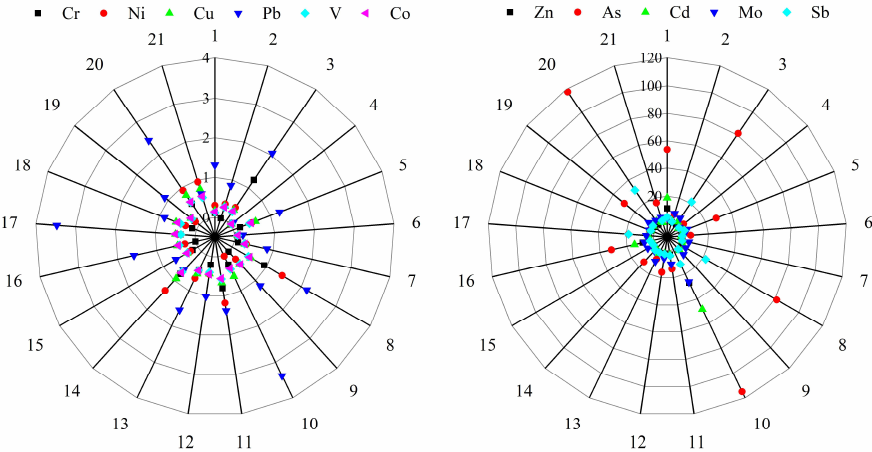
Figure 6. Polar plot of heavy metal enrichment factor (EF) values in the surface sediments of the Feiyun River Basin.